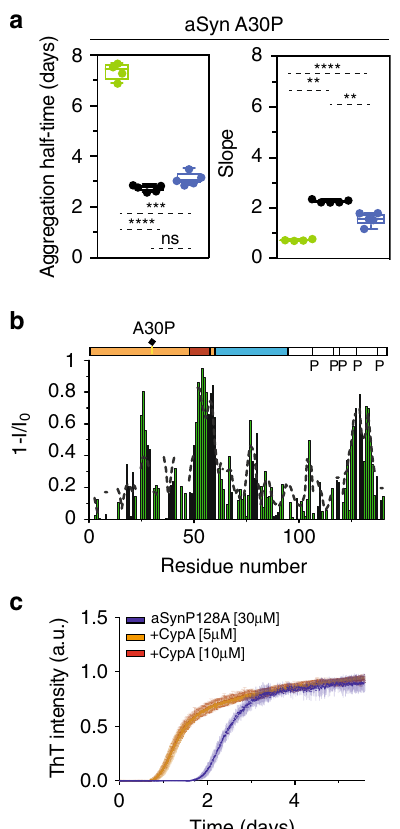
Fig. 4 CypA overcomes the A30P Parkinson ’ s disease-associated isomerization barrier. a Aggregation kinetics of A30P aSyn in the absence (green) and presence of CypA. Data from aSyn:CypA molar ratios of 3:1 and 6:1 are shown in blue and black, respectively. One-way ANOVA analysis: ns = P > 0.05, “ * ” = P ≤ 0.05, “ ** ” = P ≤ 0.01, “ *** ” = P ≤ 0.001, “ **** ” = P ≤ 0.0001. n = 5 independent experiments were performed for the aggregation of A30P aSyn in the presence and absence of CypA. One point of A30P aSyn aggregation was excluded from the analysis due to its low aggregation propensity and high deviation with respect to the mean value. Box plots represent the median (middle line), 25th, and 75th percentile (box), while the whiskers span from the minimum to the maximum value. b Residue-speci fi c intensity changes observed in 1 H – 15 N HSQC spectra of A30P aSyn upon addition of a fi vefold excess of CypA. The CypA-induced intensity-broadening pro fi le of wild-type aSyn is shown as a dashed line. c , ThT- fi brillization assay of the P128A-mutant aSyn protein alone (30 μ M, blue) and in the presence of substoichiometric concentrations of CypA. Data points represent the mean values from n = 5 independent experiments ±1 af fi nity of the PreNAC region upon C-terminal truncation of aSyn indicates that the PreNAC and the C-terminal proline-rich region of aSyn compete for binding to the active site of CypA.